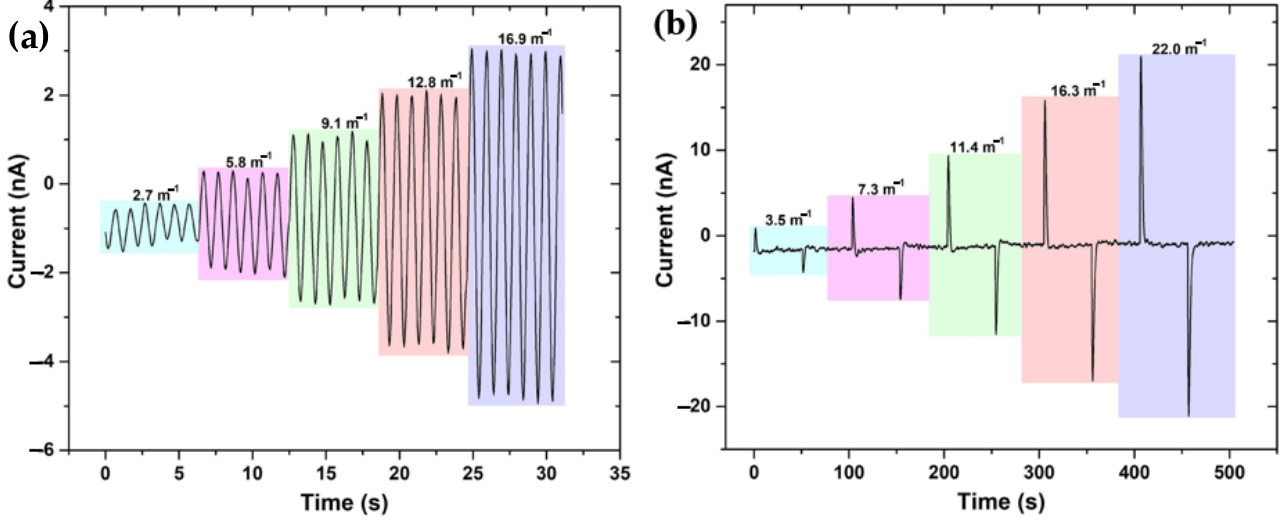
Figure 2. Flexo-ionic effect due to sinusoidal and intermittent cantilever bending ( a ) current response due to sine wave (1 Hz) bending with different curvatures ( b ) current response due to square wave (10 mHz) bending with different curva ‐ tures.